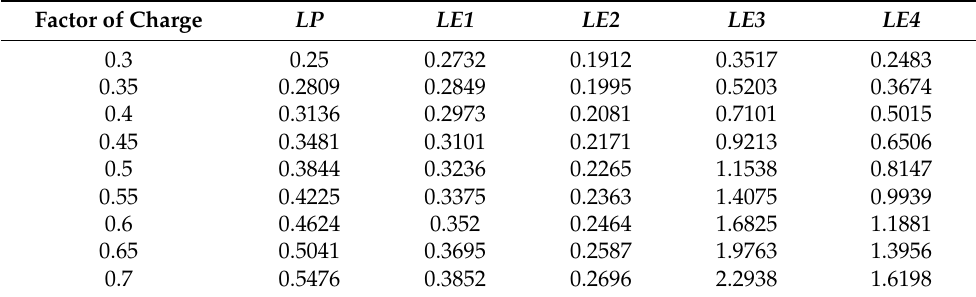
Table 3. Coefficients of equations for k =